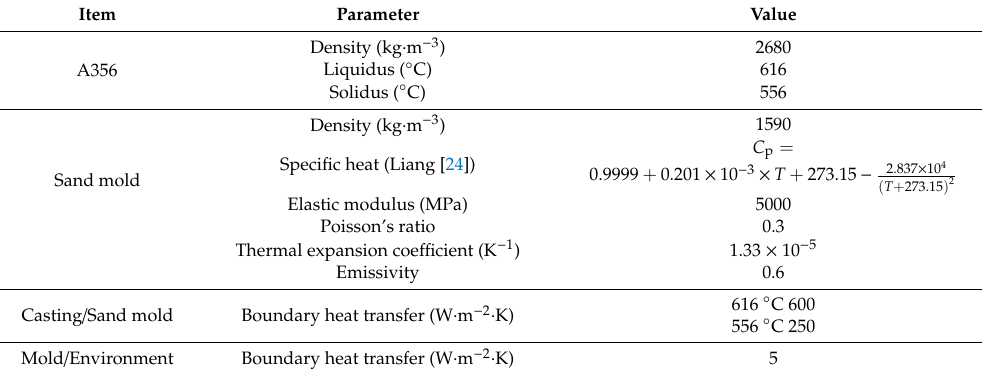
Figure 6. Thermal properties of sand mold: ( a ) thermal conductivity and ( b ) specific heat. Table 1. Other thermal and mechanical properties of A356 and sand mold.